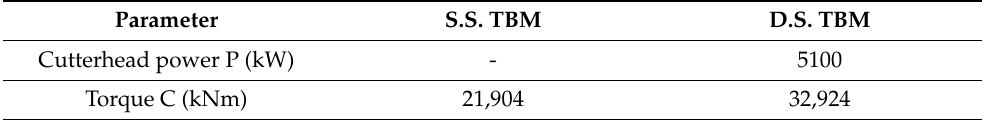
Table 7. Minimum values of P and C with which the two types of TBM must work in rock formations with the presence of schists, having chosen a diameter of 11 m.